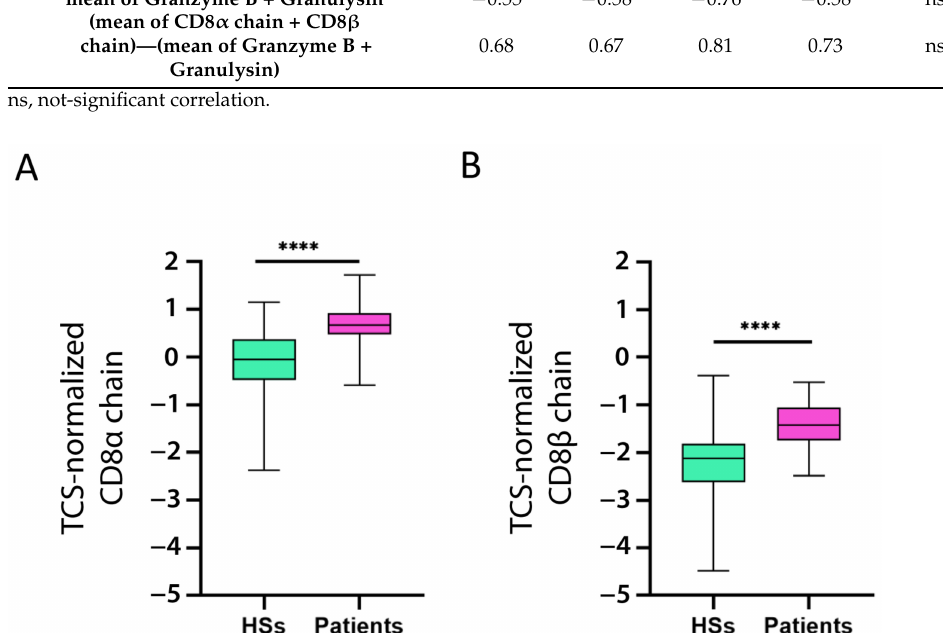
Figure 5. Increased CD8 chain expression in patients with B-ALL. CD8 α chain ( A ) and CD8 β chain ( B ) mRNA expression (log2) in patient and healthy subject (HS) PBMC was normalized with the T cell signature (TCS) expression levels (log2). The data are represented as box-and-whisker plots. The box limits represent the 1st and 3rd quartiles. The median is represented as a line within the box. The whiskers go down to the smallest and up to the largest value. The significant difference between patients and HSs was evaluated using the t -test. **** p <